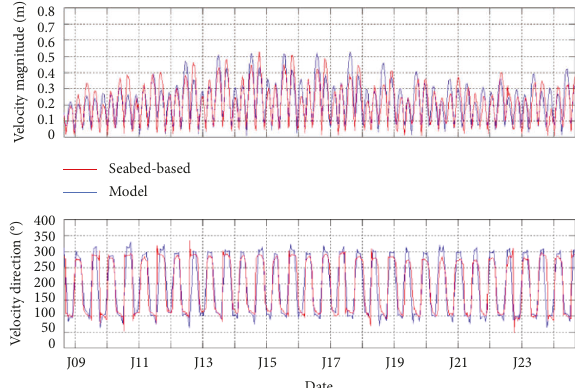
Figure 2: Water velocity of simulation and